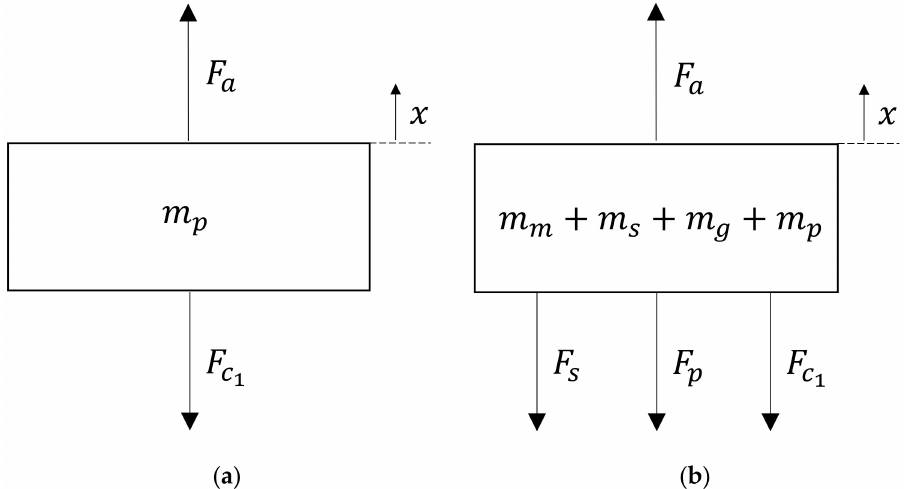
Figure 3. Free body diagram: ( a ) Motion of Phase 1; ( b ) Motion of Phase 2.